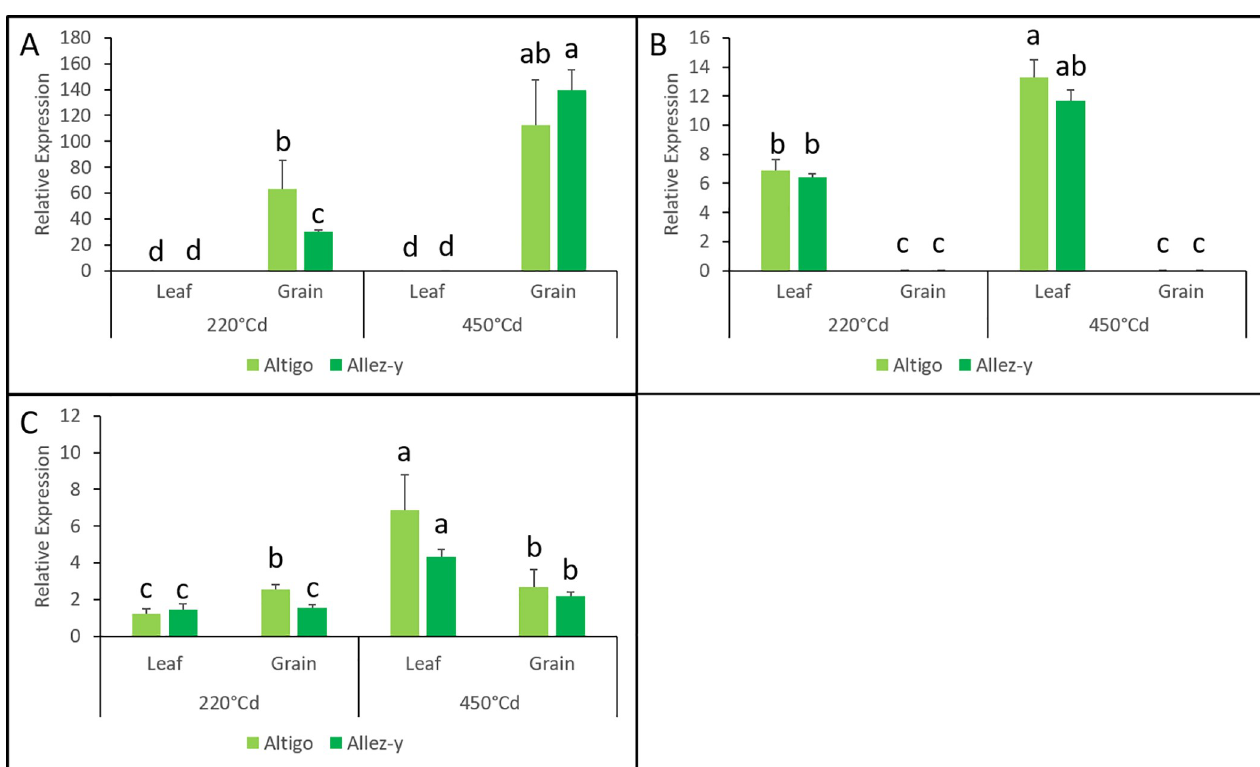
Fig 8. RT-qPCR analysis of three TaNAC genes (TraesCS5A01G245900.2 (A), TraesCS7D01G315100.1 (B), and TraesCS2A01G101100.1 (C)) in leaves and grains at 220˚Cd and 450˚Cd in irrigated conditions. Mean values and standard deviation were obtained from three replicates. According to a Kruskal- Wallis test, the same letter indicates no significant